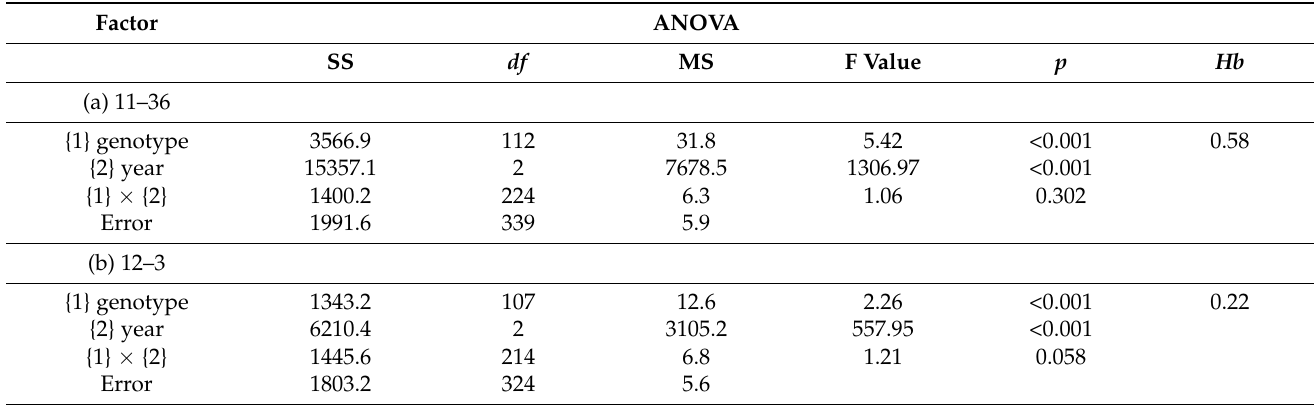
Table 2. Analysis of variance for tuber dry rot lesion size, evaluated in three years in the diploid potato mapping populations 11–36 (a) and 12–3